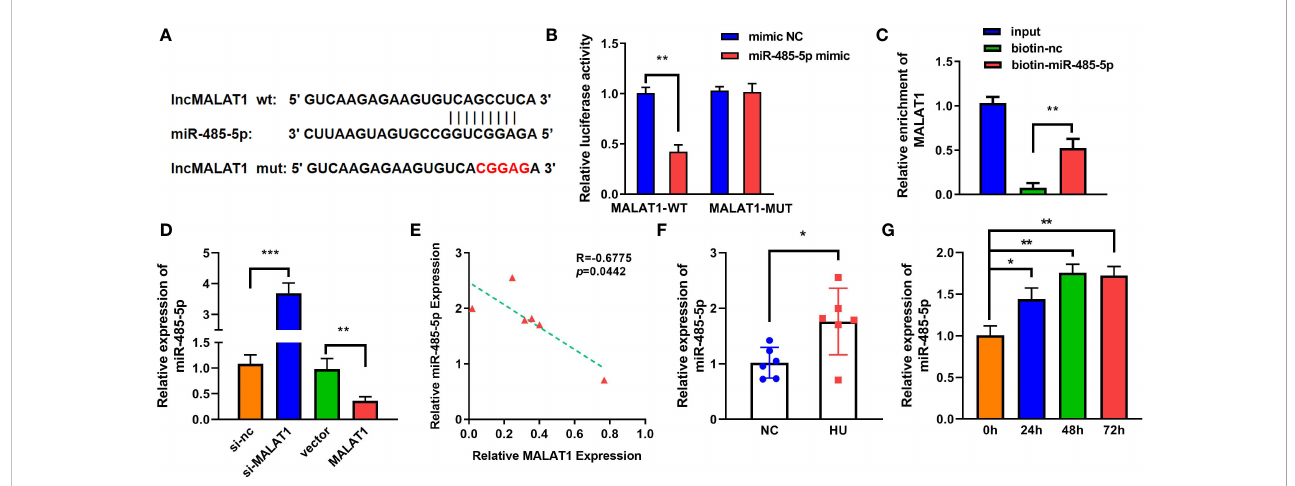
FIGURE 4 MALAT1 acted as a miRNA sponge of miR-485-5p. (A) The binding sites of wild-type (wt) MALAT1 and miR-485-5p were shown. Meanwhile, mutant (mut) MALAT1 sequences were also shown. (B) The targeting relationship between MALAT1 and miR-485-5p was con fi rmed by luciferase reporter assay. (C) The targeted relationship between MALAT1 and miR-485-5p was veri fi ed using RNA pull-down. (D) The expression of miR-485-5p was measured by RT-qPCR after overexpression or MALAT1 knockdown. (E) The Pearson method was applied for correlation analysis. (F, G) The expression of miR-485-5p in the HU mice and MG-treated MC3T3-E1 cell was detected using RT-qPCR. * p < 0.05, ** p < 0.01, *** p <